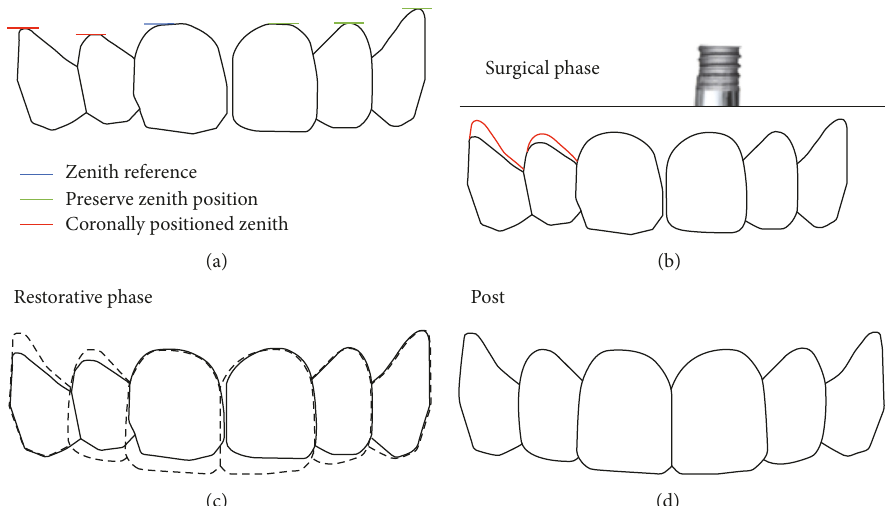
Figure 2: The evaluation of the maxillary anterior teeth demonstrated the alteration of teeth form, zenith position of teeth 13 and 12, and the need to preserve the marginal tissue on tooth 21 after